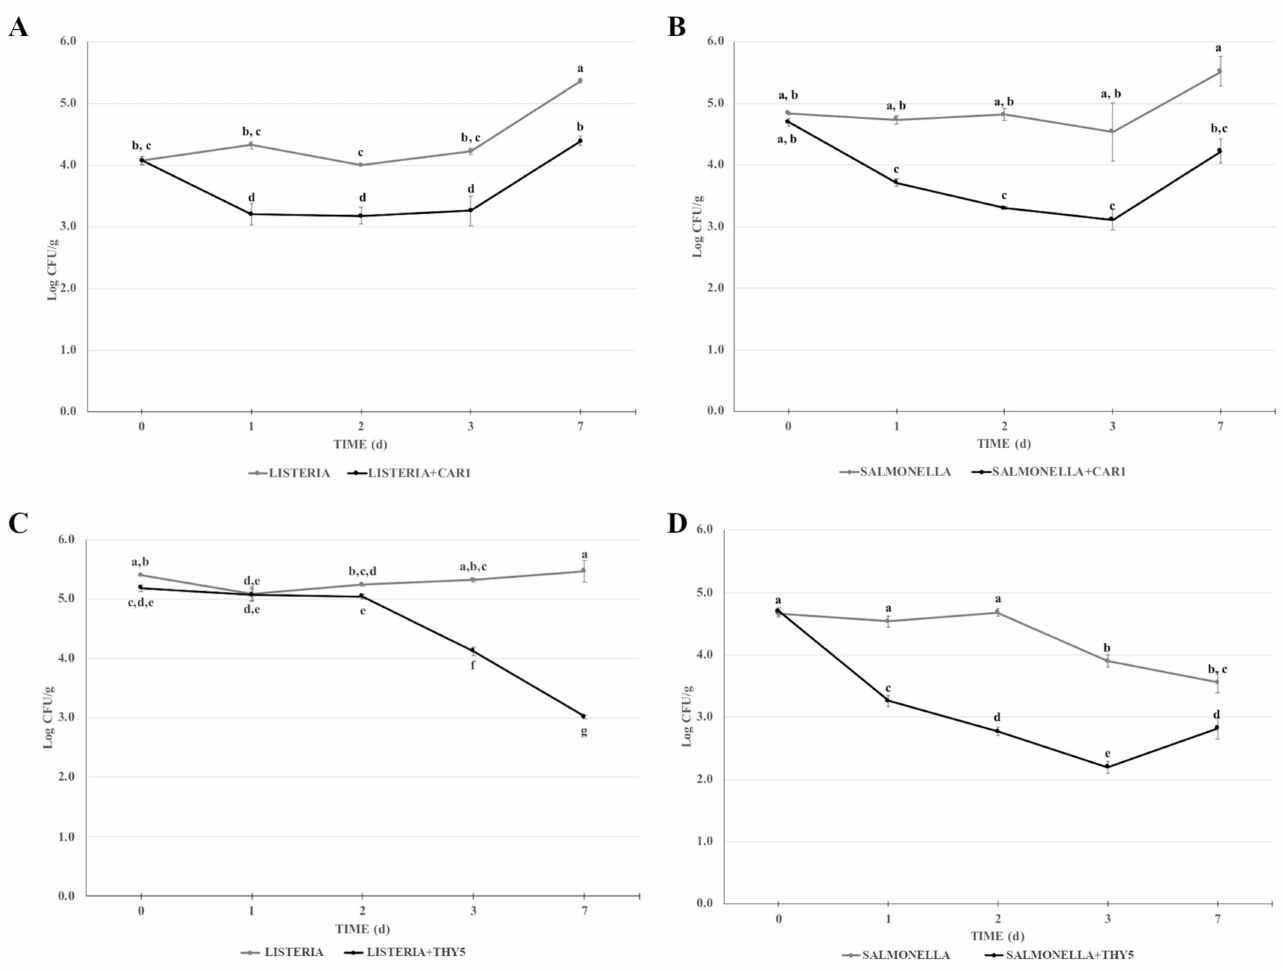
Figure 3. Challenge test of CAR1 against ( A ) L. monocytogenes OH and ( B ) S . Typhimurium LT2 and of THY5 against ( C ) L. monocytogenes OH and ( D ) S . Typhimurium LT2. The assay was performed in minced cow meat artificially contaminated with L. monocytogenes OH or S . Typhimurium LT2, with or without the addition of 0.5% CAR1 or THY5. The meat was stored at 4 ◦ C for up to 7 days, homogenized at the indicated timepoints and appropriate dilutions were plated. Bacterial cell viability is expressed as the geometric mean of CFU/g ± SD of one experiment carried out in triplicate. Means without a common letter significantly differ, p <